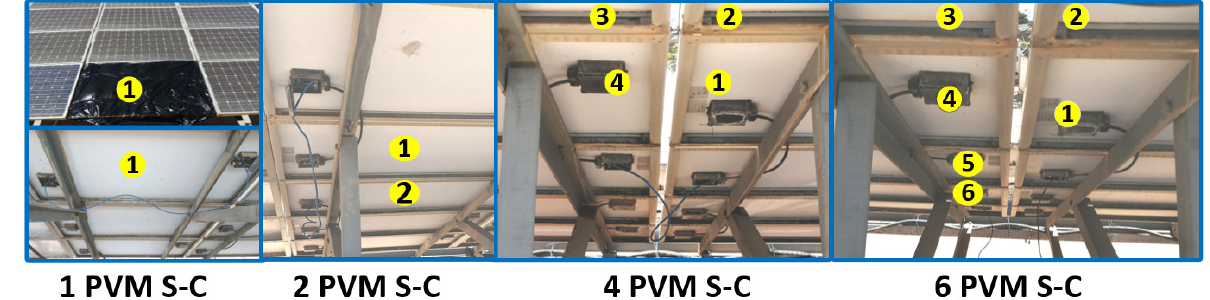
Figure 27. Photo of some scenarios of PV modules (PVM) in short circuit (S-C).